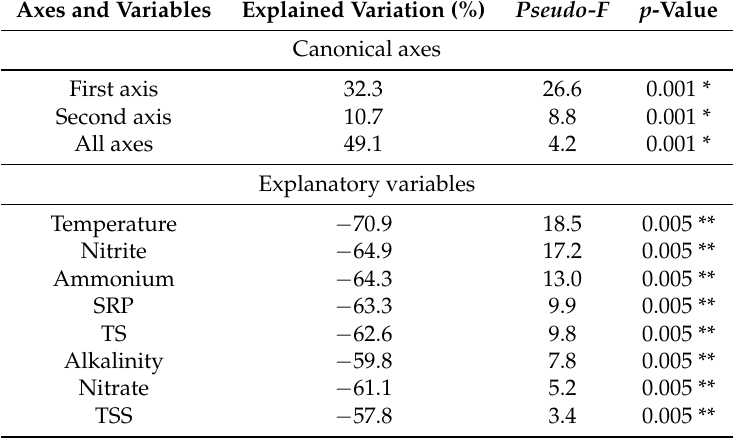
Table 2. Redundancy analysis (RDA) results showing the variance of the macroinvertebrate data explained by canonical axes and explanatory